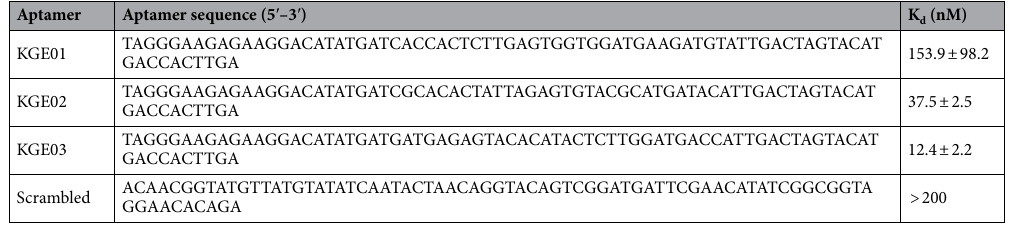
Table 1. Aptamer sequences of MLL-AF9 RAS target and their corresponding K D